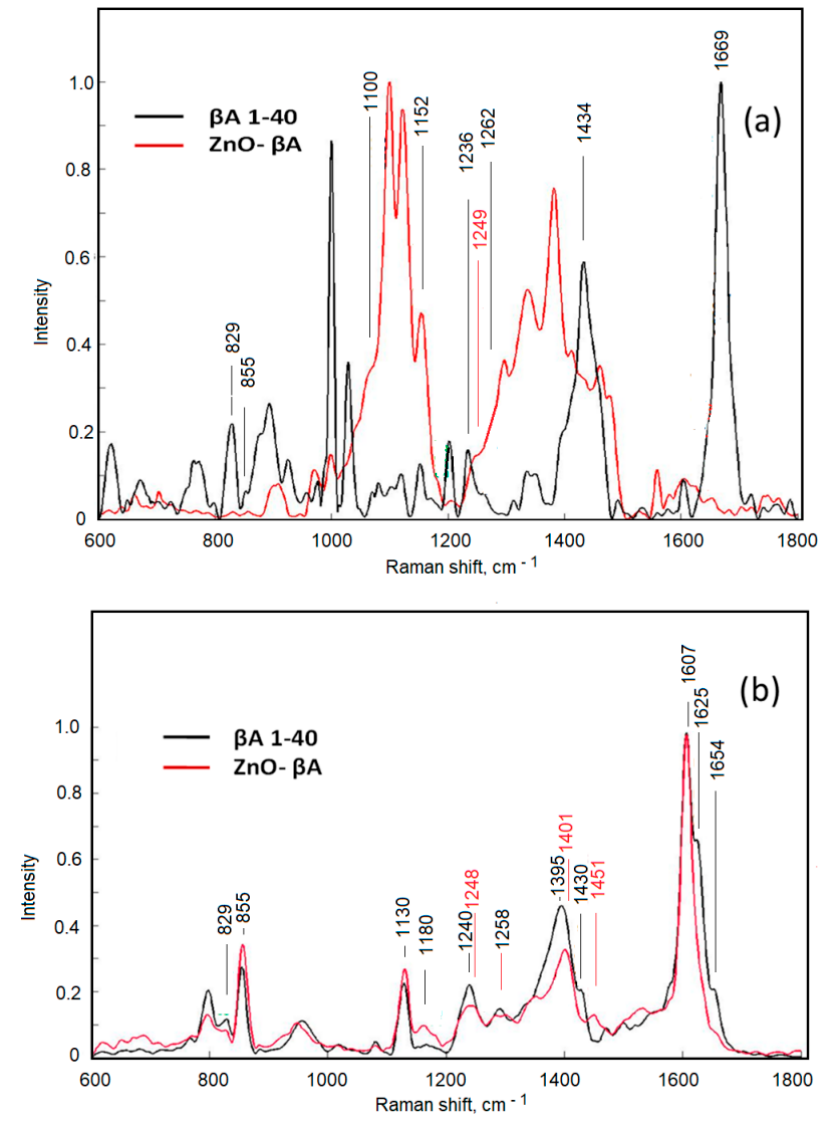
Figure 7. ( a ) Raman spectra; ( b ) SERS spectra (4 °C), of β A 1-40 (red) and ZnO- β A (black).